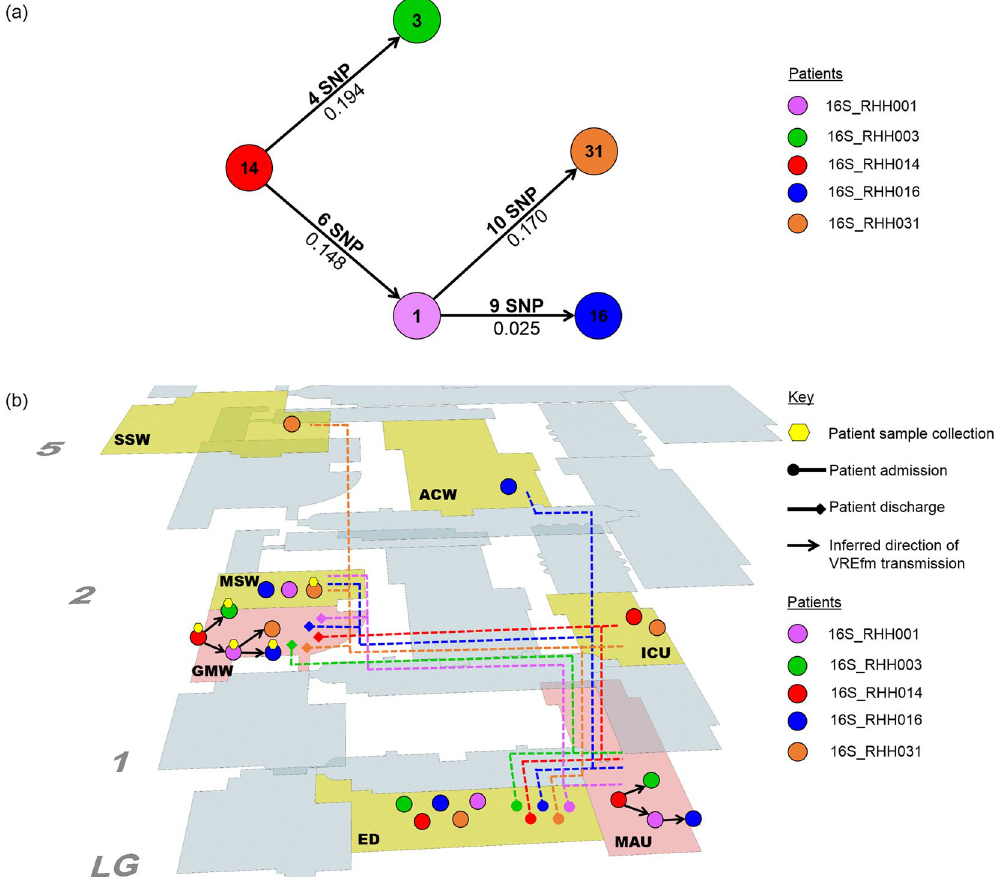
Figure 6. Vancomycin-resistant Enterococcus faecium (VREfm) transmission analysis based on single nucleotide polymorphism (SNP) genotypes of Phylogenetic Clade 2 (PC2). ( a ) Inferred VREfm transmission directions are represented by line connections between patients. Phylogenetic relationship is measured by differences in unique SNPs (numbers above connecting lines) and patristic distances between the isolates (numbers below connecting lines). ( b ) Correlation of SNP genotype data with epidemiological data revealed likely direction of transmission and potential points of transmission within the hospital. Potential points